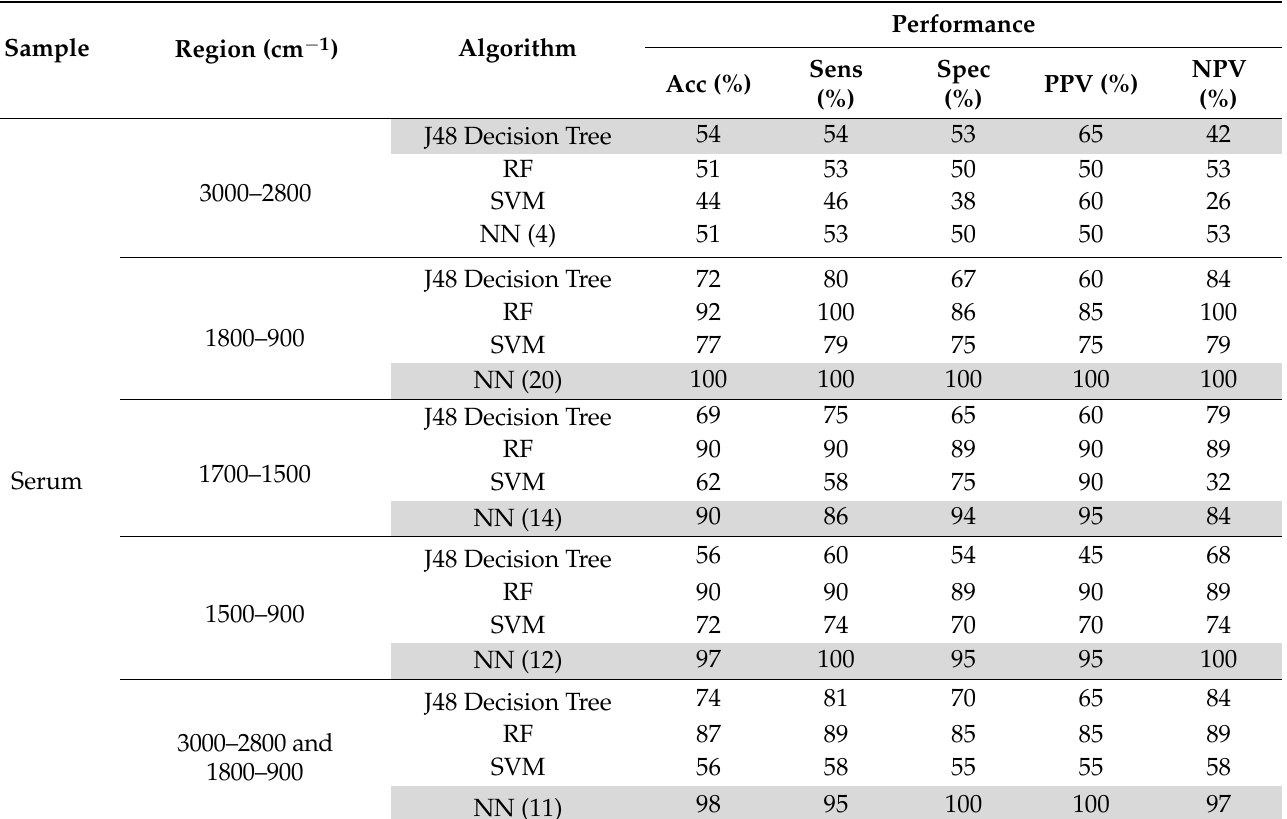
Table 2. Comparison of multiple advanced machine learning algorithms for classification models in serum